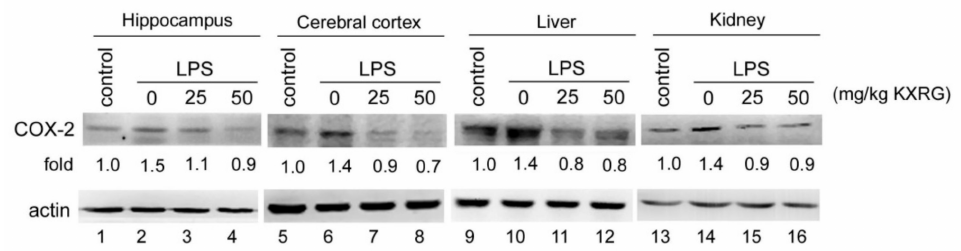
Figure 7. Western blotting analysis of COX-2 expression in the brain, liver, and kidneys. Equal amounts of protein lysates of the hippocampus, cerebral cortex, liver, and kidneys were prepared from LPS-injected mice with or without KXRG feeding. The COX-2 expression level is shown as the fold change normalized against actin and compared with the control